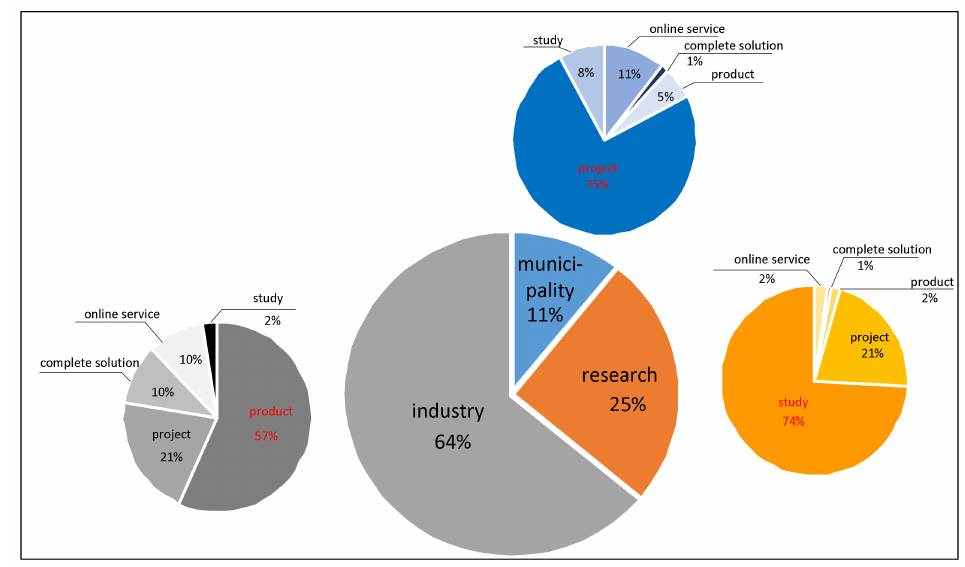
Figure 2. Distribution of the identified digitization elements ( n = 698).